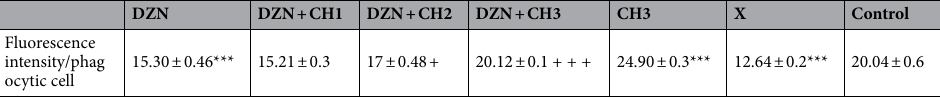
Table 2. Effect of DZN 20 mg/kg and CH 50 mg/kg, and DZN plus CH (12.5, 25, and 50 mg/kg) on phagocytic capacity of neutrophils and monocytes in BALB/c mice. Data showed as mean ± SD, (*) shows the significant changes compared to controls, ( +) comparison with DZN-treated group. p < 0.05 and (***) or (+ + + +) p < 0.001. DZN at a dose of 20 mg/kg significantly reduced phagocytic activity compared to the control group. CH, in a dose-dependent manner, significantly increased phagocytic activity compared to the control group.